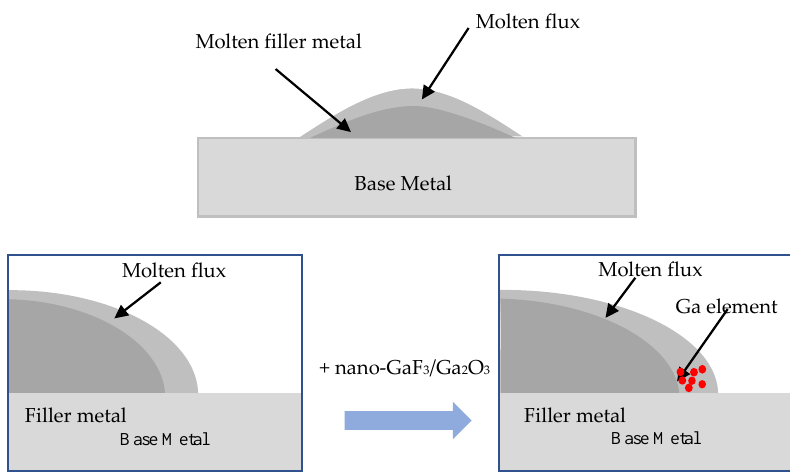
Figure 5. Diagrammatic sketch of the interfacial tension of spread Zn-Al filler metal.